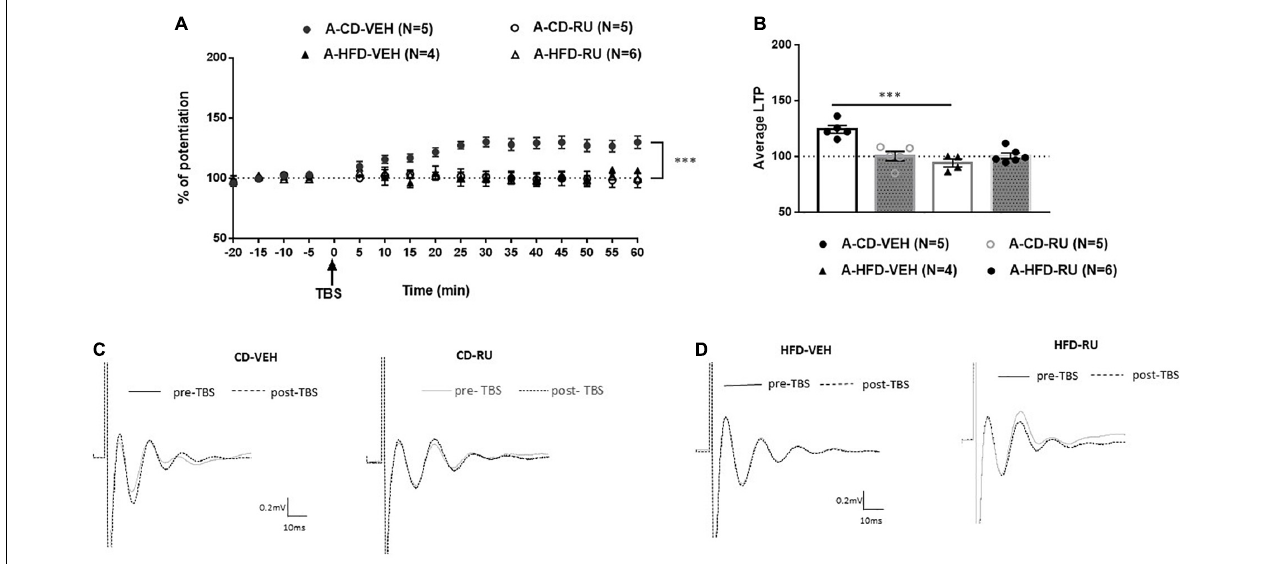
FIGURE 4 | Effects of systemic glucocorticoid receptor (GR) blockade on prefrontal LTP in HFD- and CD-fed adults. (A) Normalized field excitatory post-synaptic potentials (fEPSPs) recorded in vivo before and after TBS of the BLA-mPFC pathway. Each data point shows the average fEPSPs of the preceding 5 min. (B) Average LTP shown in panel (A) over the 60 min after TBS. (C,D) Representative average waveforms before and after TBS Horizontal bar = 10 ms; vertical bar = 0.2 mV. For adult animals systemically injected with GR antagonist RU-486 (RU) or vehicle (VEH) 30 min prior to TBS. RU treatment had no effect on HFD-impaired LTP in HFD-fed animals, but impaired LTP in control CD-fed animals. Two-way ANOVA with repeated measures on the 12 post-TBS time points showed significant effects of Diet ( ∗∗∗ p < 0.001), Drug ( ∗∗∗ p < 0.005), and Diet × Drug interaction ( ∗∗∗ p < 0.001). Post hoc analysis showed a significant difference in CD-fed animals between vehicle and RU-486 groups ( ∗∗∗ p < 0.001), and no significant difference between HFD-treated groups. Error bars show standard error of the mean (SEM).